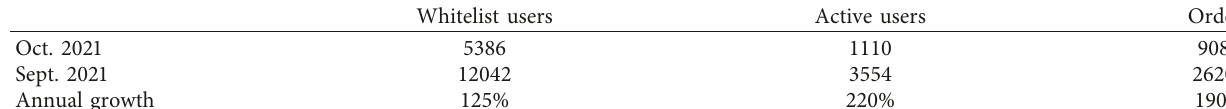
Figure 6: Recommended indicator 3: example of TUR. Table 2: Growth of users and orders.